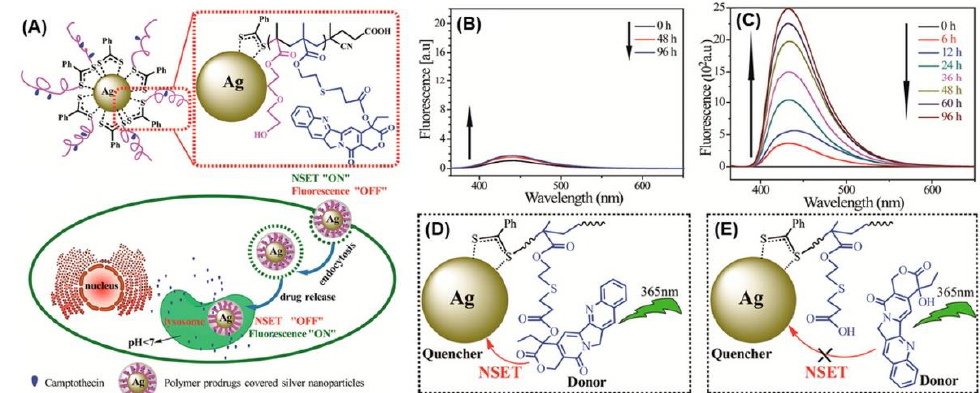
Figure 9. ( A ) Schematic illustration and intracellular release of CPT. Principle of NSET (nanoparticle surface energy transfer) “on” and “off” for the P(HEO2MA-co-MACPT)@AgNPs. Fluorescence spectra of the hybrid AgNPs after incubation in PBS solution at pH 7.4 ( B ) and at pH 5.0 ( C ) for different times. Schematic diagrams of NSET “on” ( D ) and NSET “off” ( E ) for the P(HEO2MA-co-MACPT)@AgNPs. Reproduced from [154] with permission, copyright 2017, American Chemical